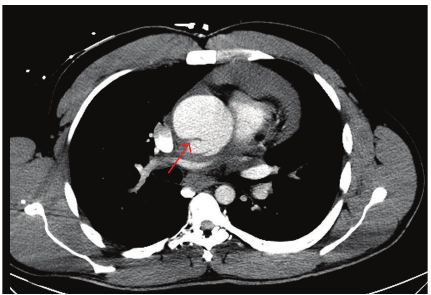
Figure 5: CT scan of chest with contrast showing dissection flap in ascending aorta (red arrow).